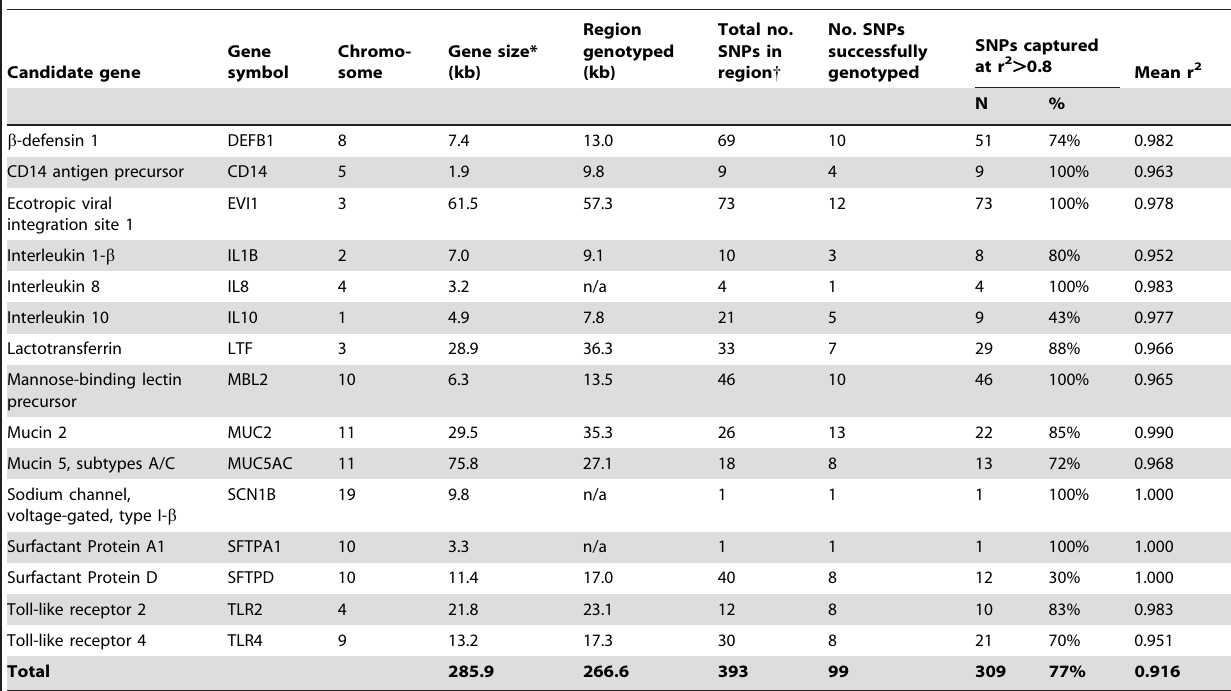
Table 1. Selected candidate genes and number of SNPs genotyped.